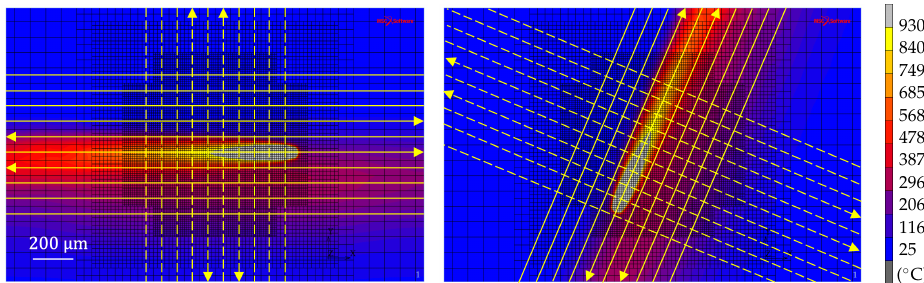
Figure 4. Illustration of the scanning strategy in layers one and two showing the laser scanning vectors for the first and second scan (solid and dashed lines, respectively). The scanning strategy is rotated 67 ◦ between the layers. The colour contours show the simulated temperature field ( ◦ C) from room temperature to the melting temperature of 930 ◦